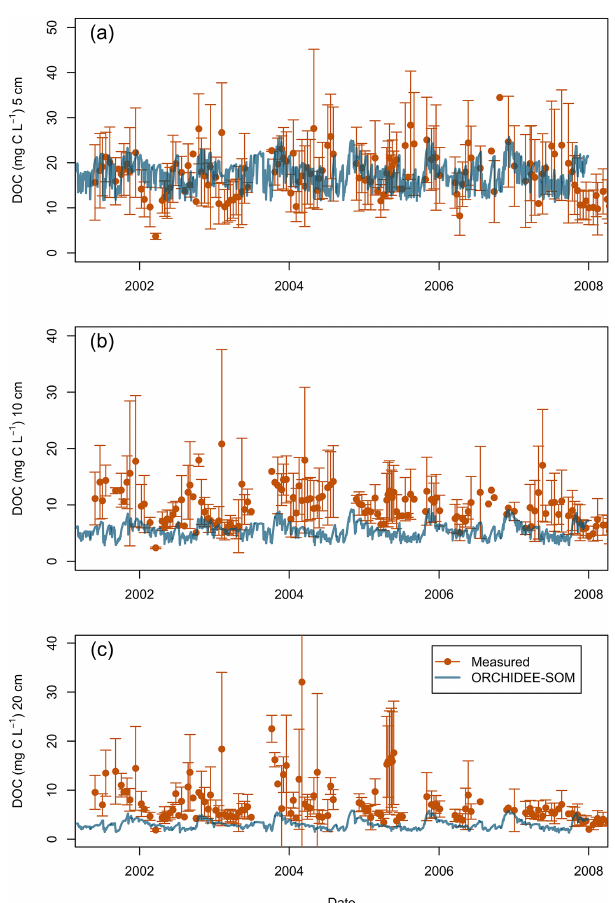
Figure 5. ORCHIDEE-SOM simulated (daily values) and measured DOC dynamics at Hainich forest at three soil depths: (a) 5cm, (b) 10cm, and (c) 20cm. Error bars represent the standard deviation of site measurements ( n = 4).